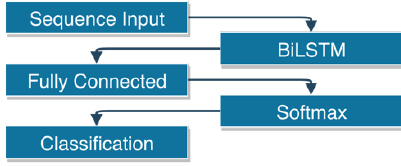
Figure 14. The used neural